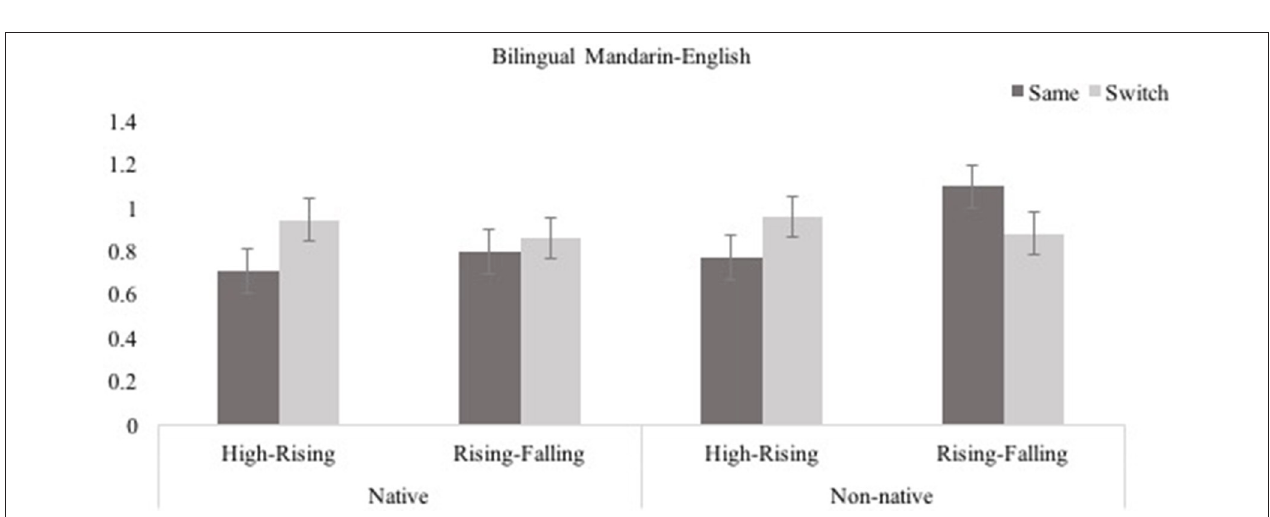
FIGURE 4 | Bilingual Mandarin-English infants’ performance in the four conditions of the switch task (Experiment 2; error bars show